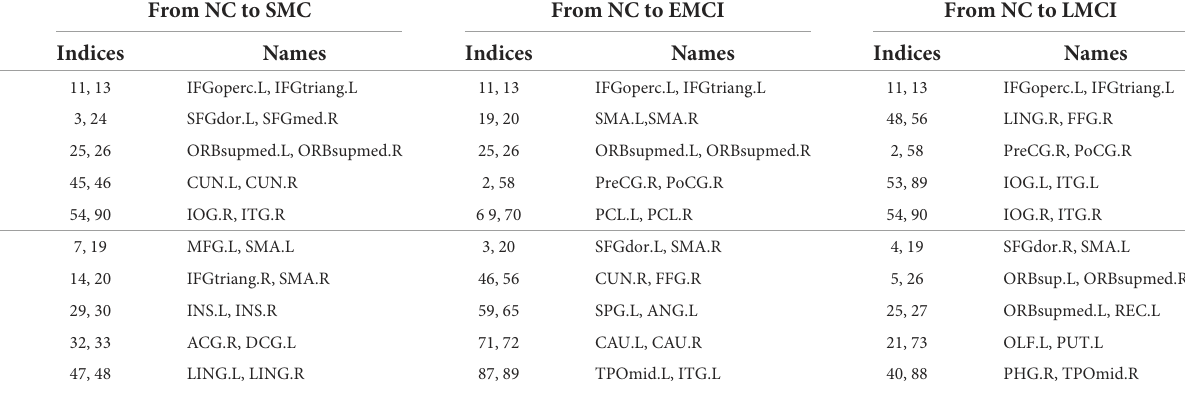
TABLE 1 The top 10 significant altered connections estimated from the generated FBNs in NC vs. SMC, NC vs. EMCI, NC vs. LMCI using AAL90 template ( − means reduced connections, + means increased connections). From NC to SMC